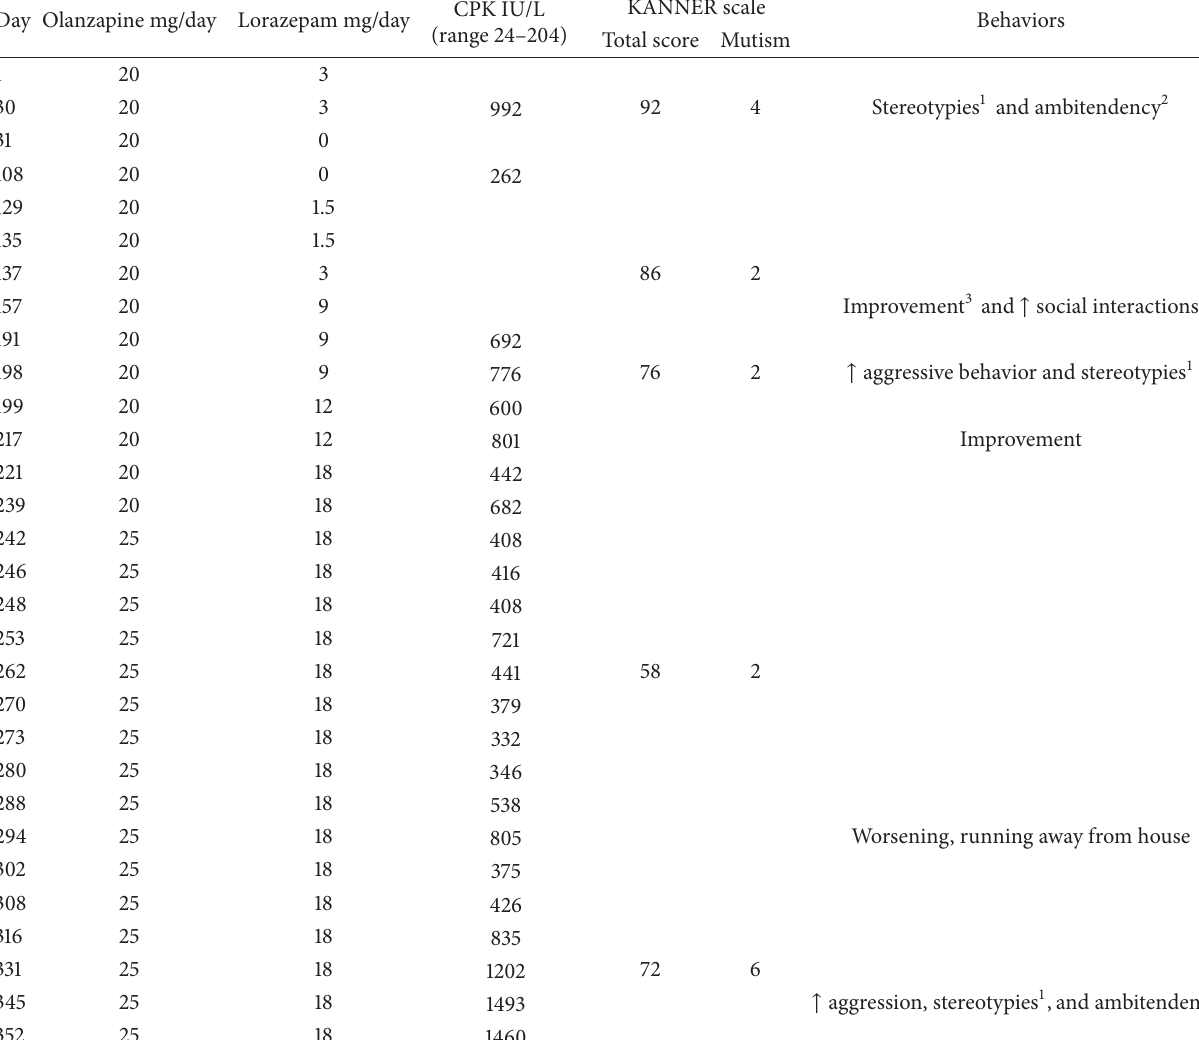
1460 1 Stereotypies: the most characteristic stereotype associated with catatonic symptoms was rubbing and scratching his bottom to the point of irritating the skin. 2 Ambitendency: the patient appeared motorically stuck in indecisive, hesitant movements [27]. The patient would go back and forth from the shower and get dressed and undressed. 3 The patient was described as the “best ever” by